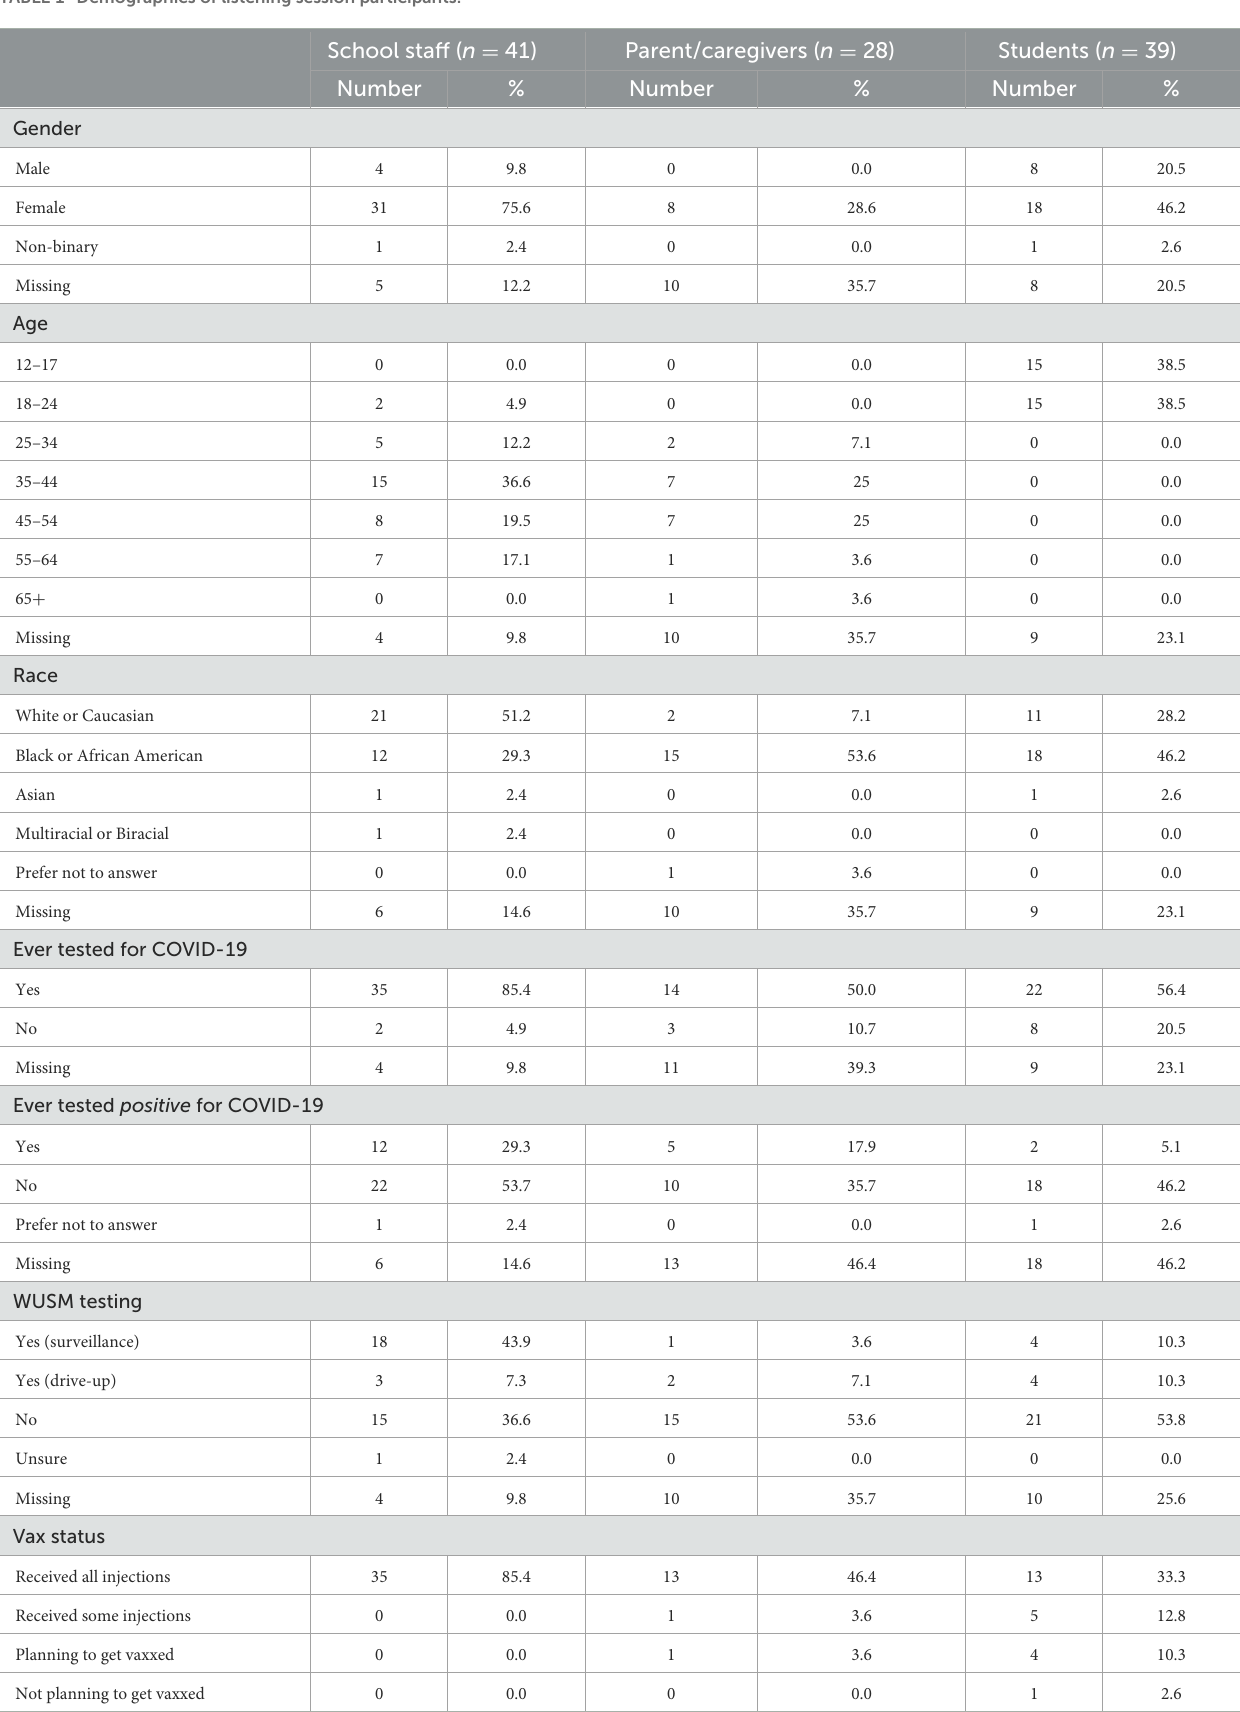
TABLE 1 Demographics of listening session